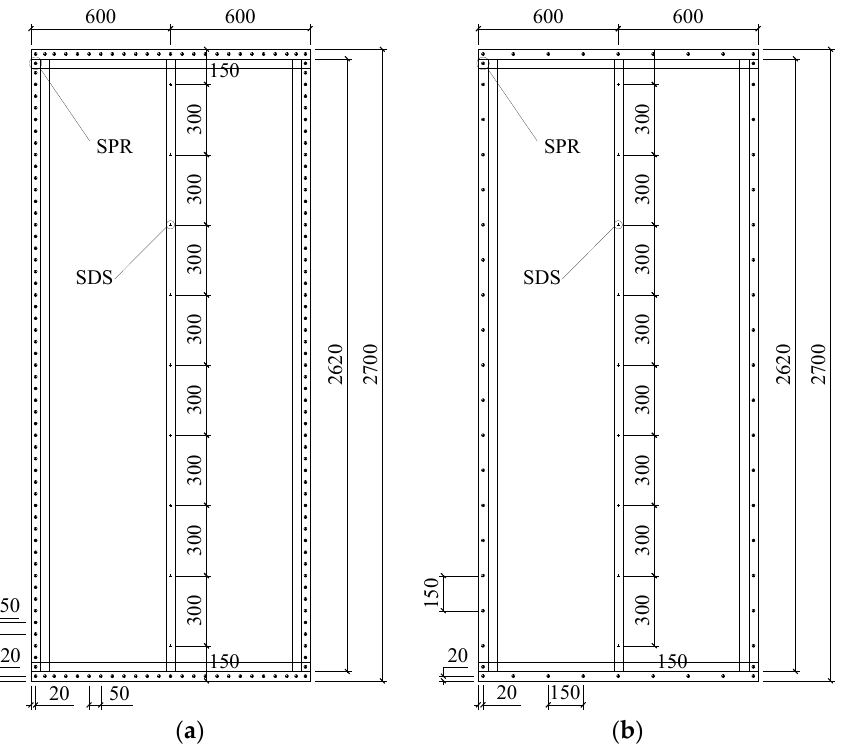
Figure 14. Specimens of CFS shear walls with SPR (mm): ( a ) W-1, ( b ) W-2.